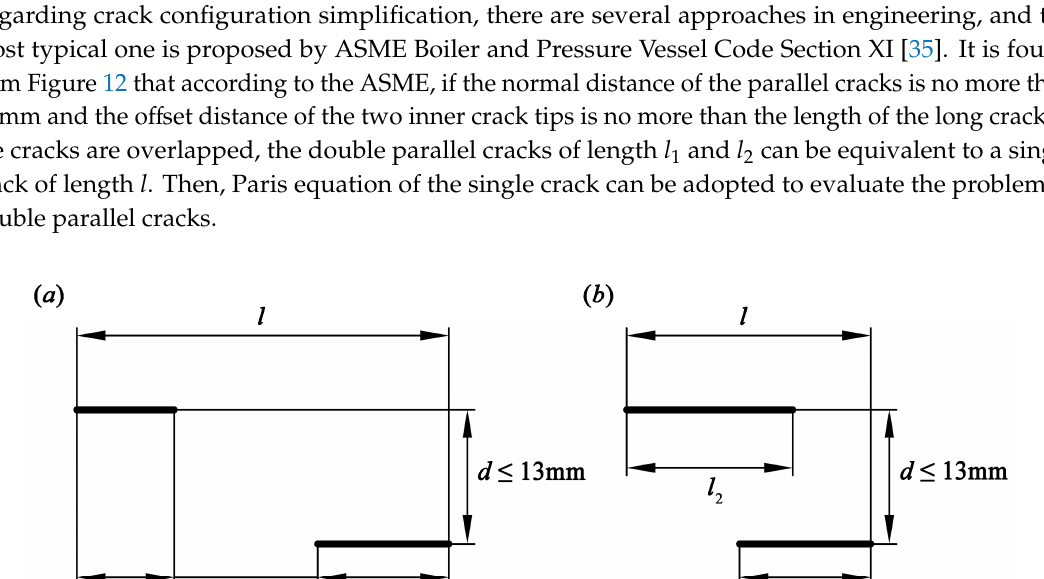
Figure 12. Method for simplification of double parallel cracks proposed by ASME: ( a ) nonoverlapping cracks and ( b ) overlapping cracks.